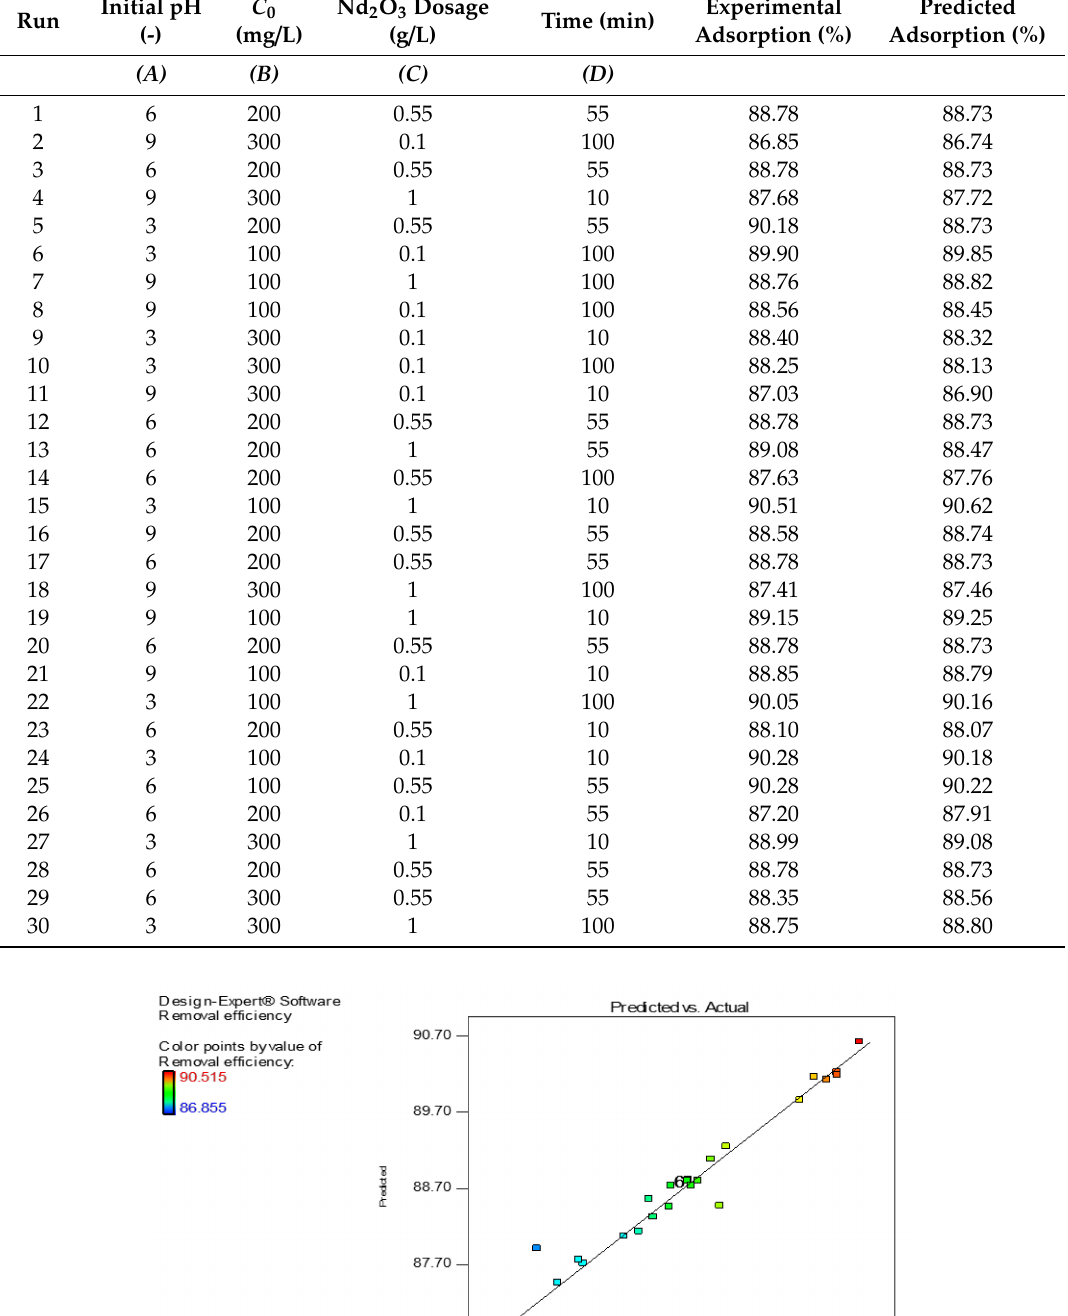
Table 2. Experimental design matrix for AB92 adsorption on Nd 2 O 3 nanoparticles.